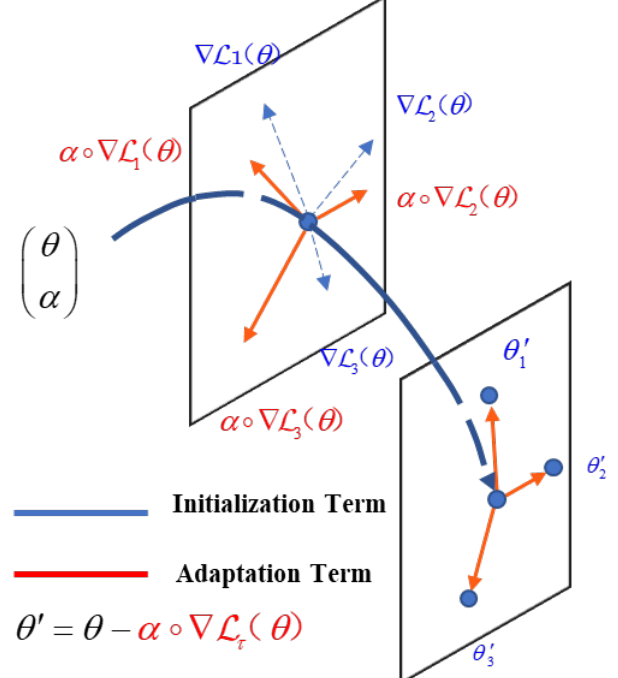
Figure 3. Illustrating the two-stages of meta-learner. Initialization term fuses cross-task information in specific scenarios, at meta-space ( θ , α ) that learns the meta-learner. Adaptation term is carried out by the meta-learner in the learner space θ that learns task-specific learners.